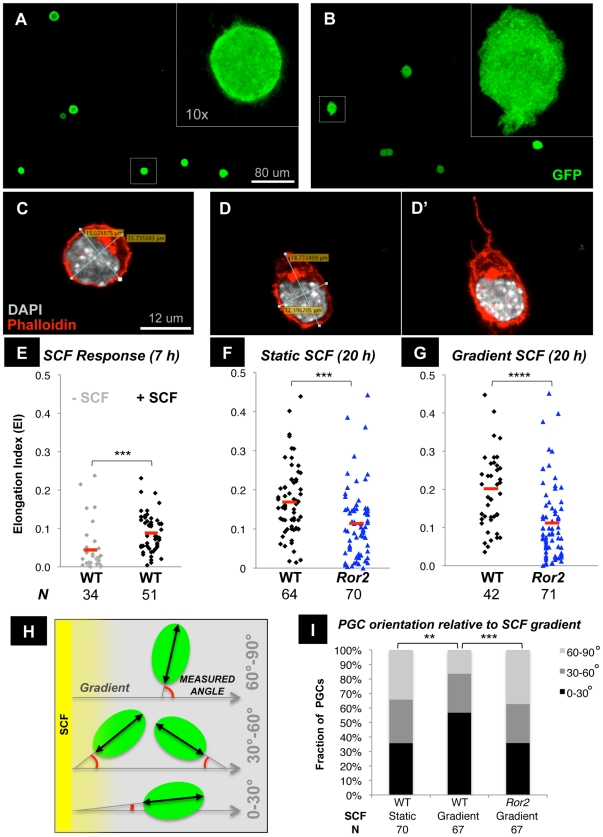
Impaired elongation and alignment with an SCF gradient in cultured Ror2Y324C PGCs.(A–B) Sorted e9.5 Oct4-ΔPE-GFP+ PGCs cultured 7 h on trigel without SCF (A) and with 50 ng/ml SCF (B), inset magnified 10×. (C–G) Cell axis measurements of the largest plane of the cell performed after staining with Phalloidin and DAPI are shown for representative round (C) and elongated (D) PGCs cultured ex vivo. A maximal projection of the confocal stacks (D′) depicts actin filament extensions of the elongated cell. An elongation index (EI) is calculated by (ALong−AShort)/(ALong+AShort) such that round cells approximate 0. The EI of WT PGCs increases after 7 h culture in static 50 ng/ml SCF (E), and is more pronounced by 20 h in WT (F). Ror2 PGCs remain less elongated in static (p = 0.0005) as well as graded SCF (G, p = 0.0004). Cell axis measurements shown are from n≥3 experiments. (H–I) The angle between the long cellular axis and the gradient was measured to determine PGC alignment with respect to SCF (H). WT PGCs cultured 20 h in graded SCF are biased toward low angles, whereas Ror2 PGCs exhibit a more random orientation, similar to WT in static SCF (I). Cell angle data represent n = 3 experiments.